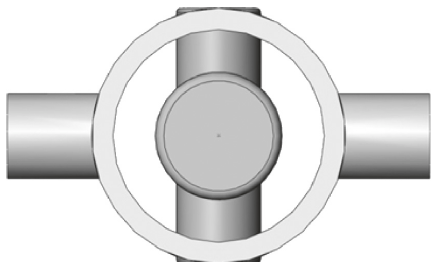
Figure 4: The 3D model of the Hooke joint.